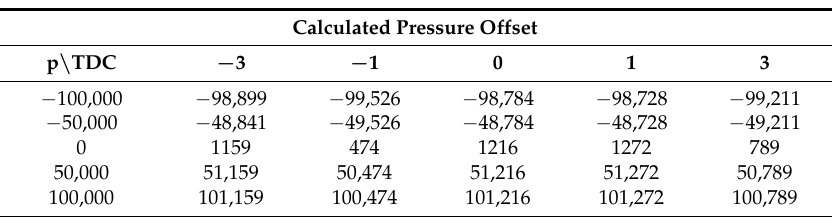
Table 5. Calculated pressure and TDC offsets and their absolute errors for the PSA engine and operating point 2000 1/min and 100 Nm using the off-line